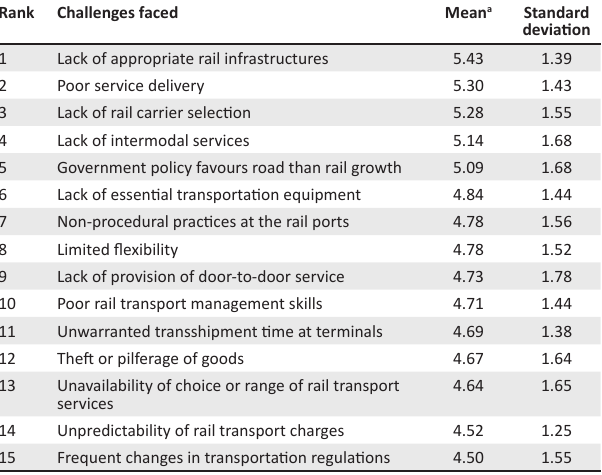
TABLE 2: Rail transport concerns in